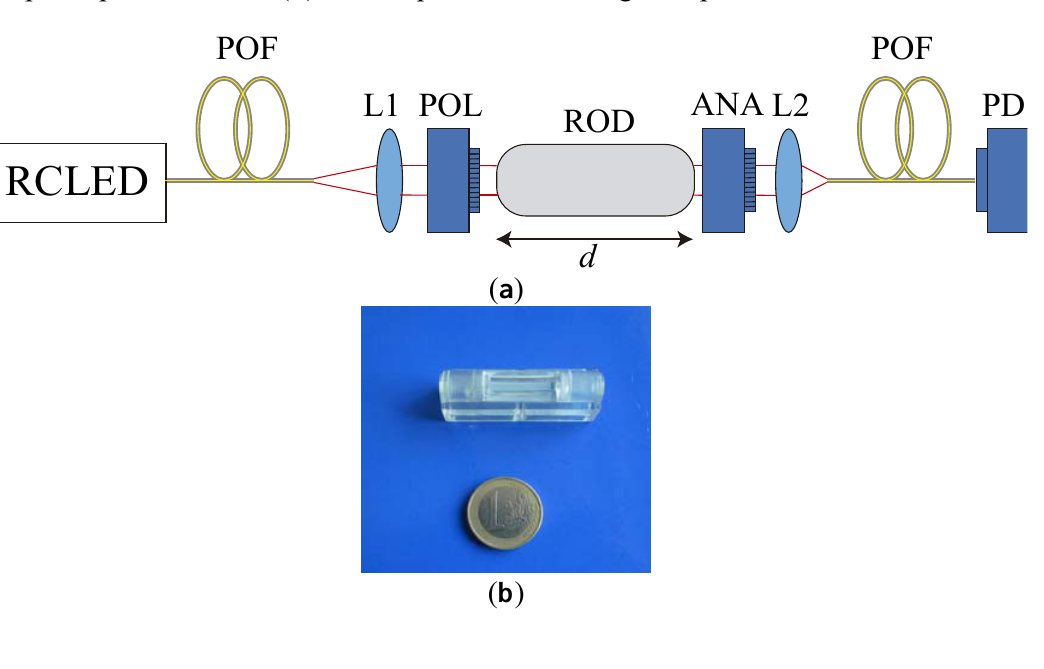
Figure 3. ( a ) Schematic representation of the optical head of the low-cost current